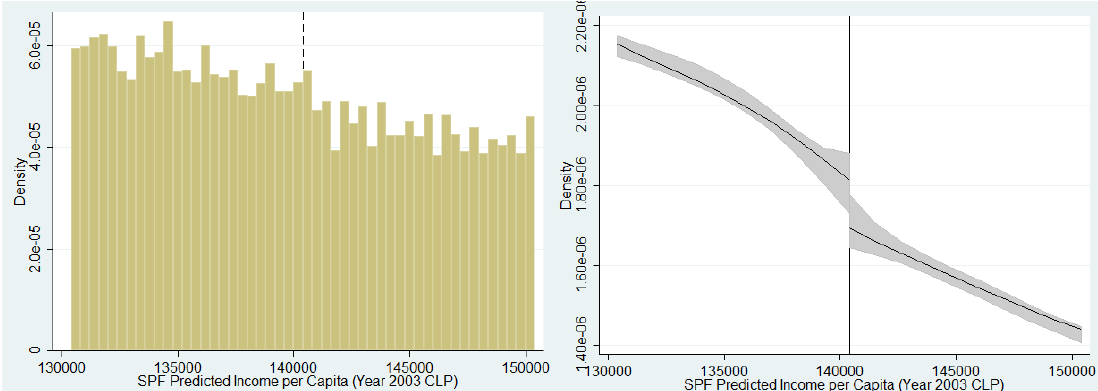
Figure 7: SPF Predicted Income per Capita Distribution and Density